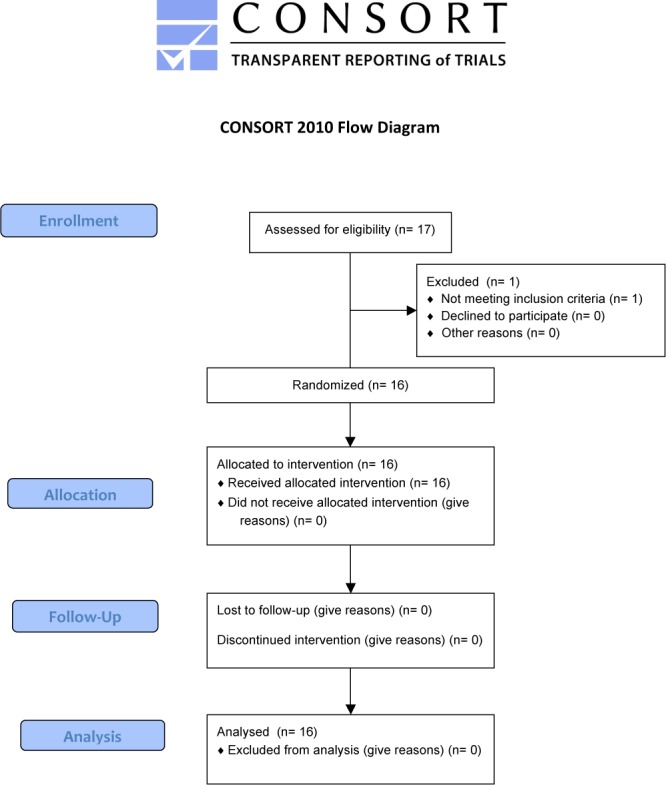
Study flow chart.One patient was excluded because of a catheter site infection which developed during screening period (before the baseline visit).